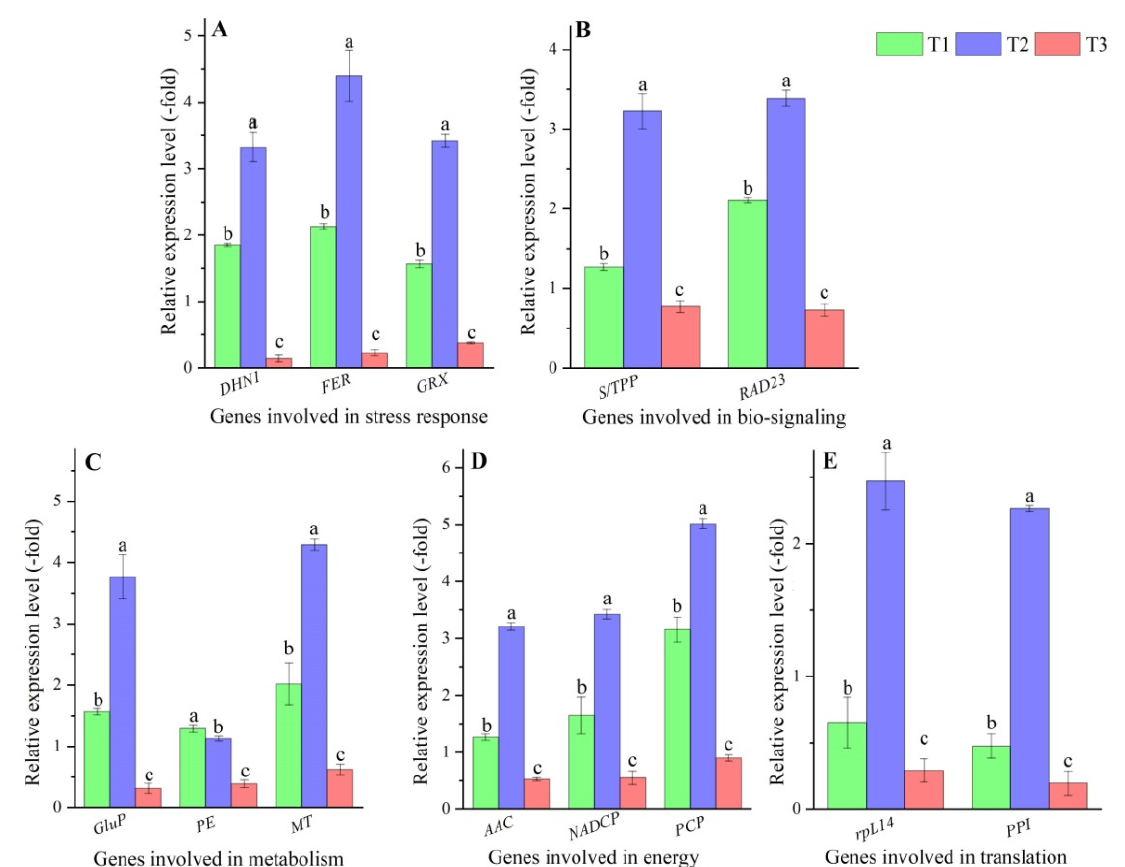
Figure 6. The relative expression level of genes involved in stress response ( A ), bio-signaling ( B ), metabolism ( C ), energy ( D ), and translation ( E ) at different treatments, determined by qRT-PCR. Different lowercase letters represent a significant difference ( p < 0.05) in the different treatments for the same gene.